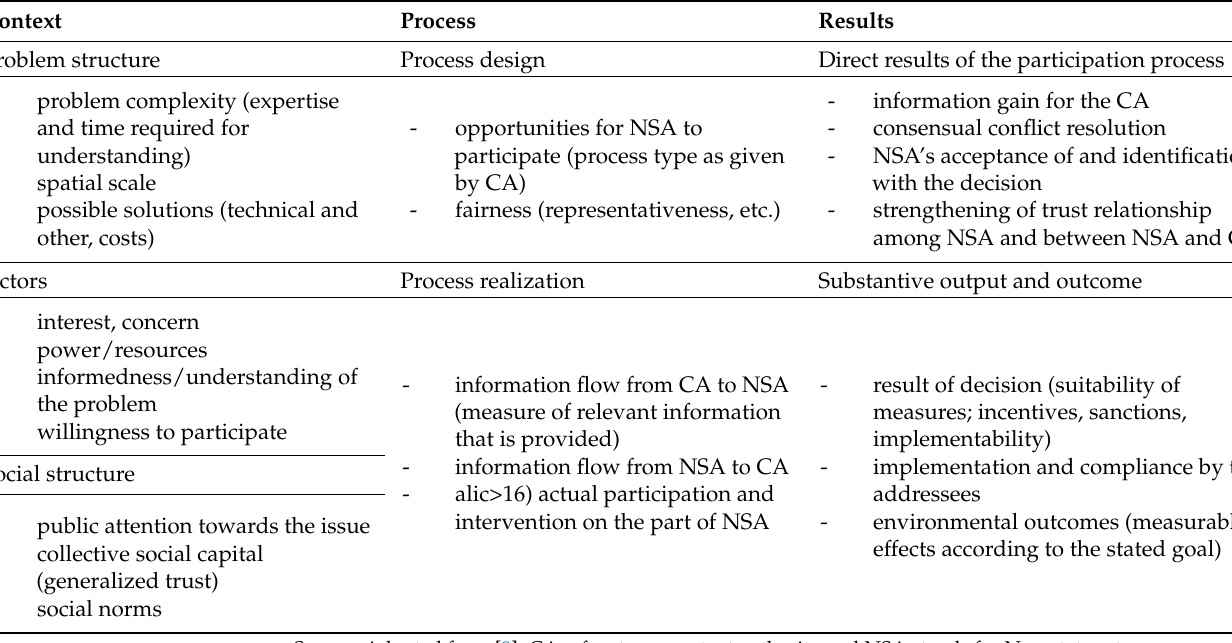
Table 1. Characteristics concerning context, process, and